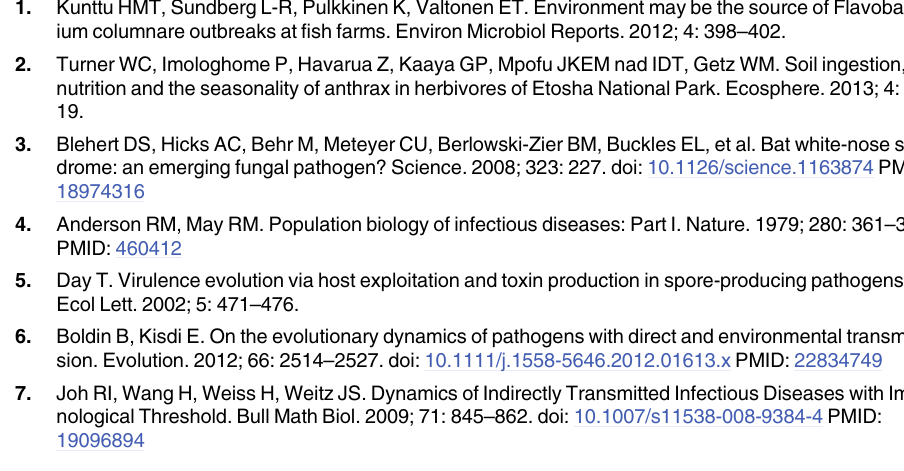
S1 Fig. Deterministic system. Infected (A) and healthy ( S + R , B) host equilibrium densities on different pathogen growth rates without environmental variation. Parameters are set as in Table 1, with immunity loss rate ρ = 0.1. Panels (C) and (D) show Jacobian matrix eigenvalue real parts and imaginary parts, respectively. (TIF) S2 Fig. Deterministic system with higher maximum infectivity. Infected (A) and healthy ( S + R , B) host equilibrium densities on different pathogen growth rates without environmental variation. Here maximum infectivity rate is higher ( β = 4.0). Otherwise parameters are set as in Table 1, with immunity loss rate ρ = 1.0. Panels (C) and (D) show Jacobian matrix eigenvalue real parts and imaginary parts, respectively. (TIF) S3 Fig. Infection peak as a response to pathogen pulse. Outbreak severities (peak areas) resulting from pulsed pathogen input to the system at an equilibrium. Parameters are set as in Table 1 (main text). Expected duration of immunity is set to average ( ρ = 0.1). (TIF) S4 Fig. Example stochastic time series. Top panel (A) shows infected (red), immunised (green), susceptible (black), and healthy (grey) host densities. Bottom panel (B) shows patho- gen densities (black) and the value of environmental stochasticity (grey) scaled to the centre of the panel. Here the environmental stochasticity is directed at pathogen growth rate r ters are set as in Table 1 (main text). Expected duration of immunity is set to average ( ρ = 0.1). (TIF) S1 Text. Analysis of deterministic system and example time-series.